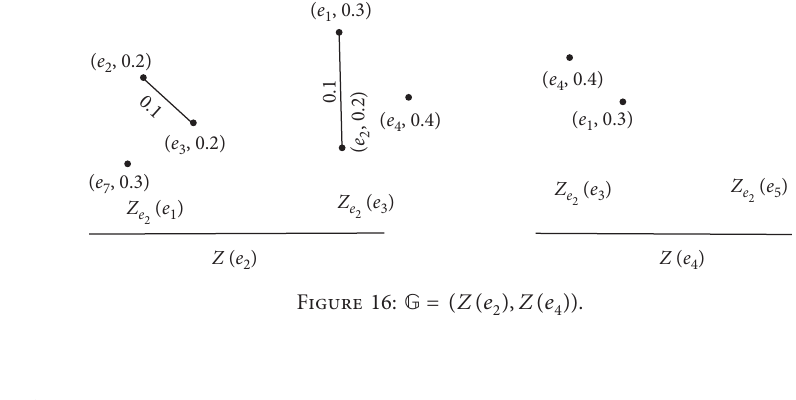
Figure 16: G � ( Z ( e